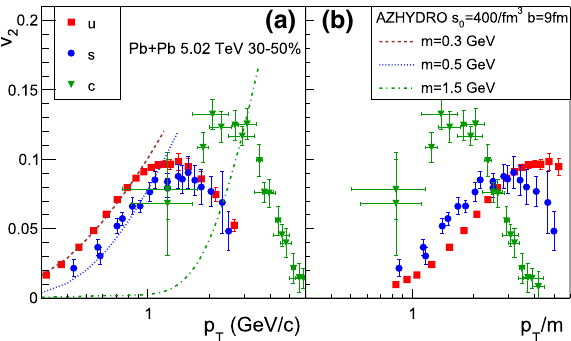
Fig. 7 v 2 of up, strange and charm quarks in Pb+Pb collisions at √ s NN = 5.02 TeV for 30–50% centrality as a function of p T ( a ) and of p T / m ( b ). Lines are results of AZHYDRO code with initial entropy density s 0 = 400 / f m 3 , impact parameter b = 9 fm, and hadronization temperature T = 0 . 165